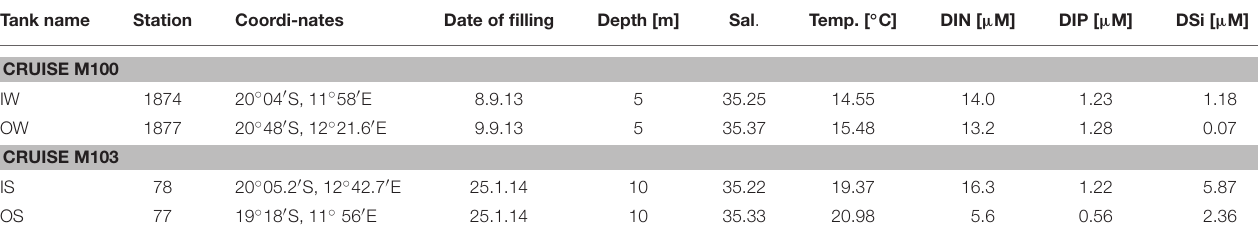
TABLE 1 | Characteristics of the upwelling water (called “inside”, tanks marked with “I”) and oceanic water (called “outside” the filaments, tanks marked with “O”) for filling the